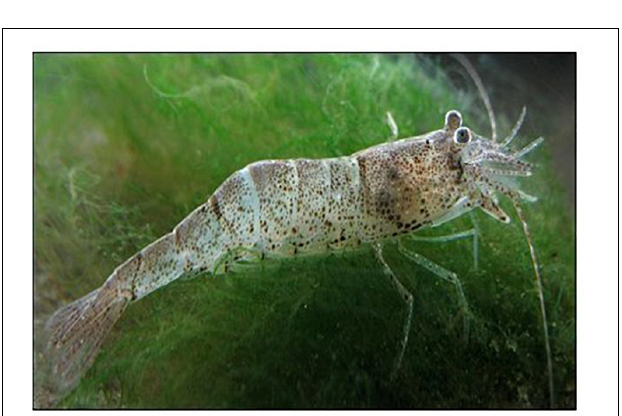
FIGURE 1 | Tributyltin treated (left) and untreated (right) marine exposed during 1 month.